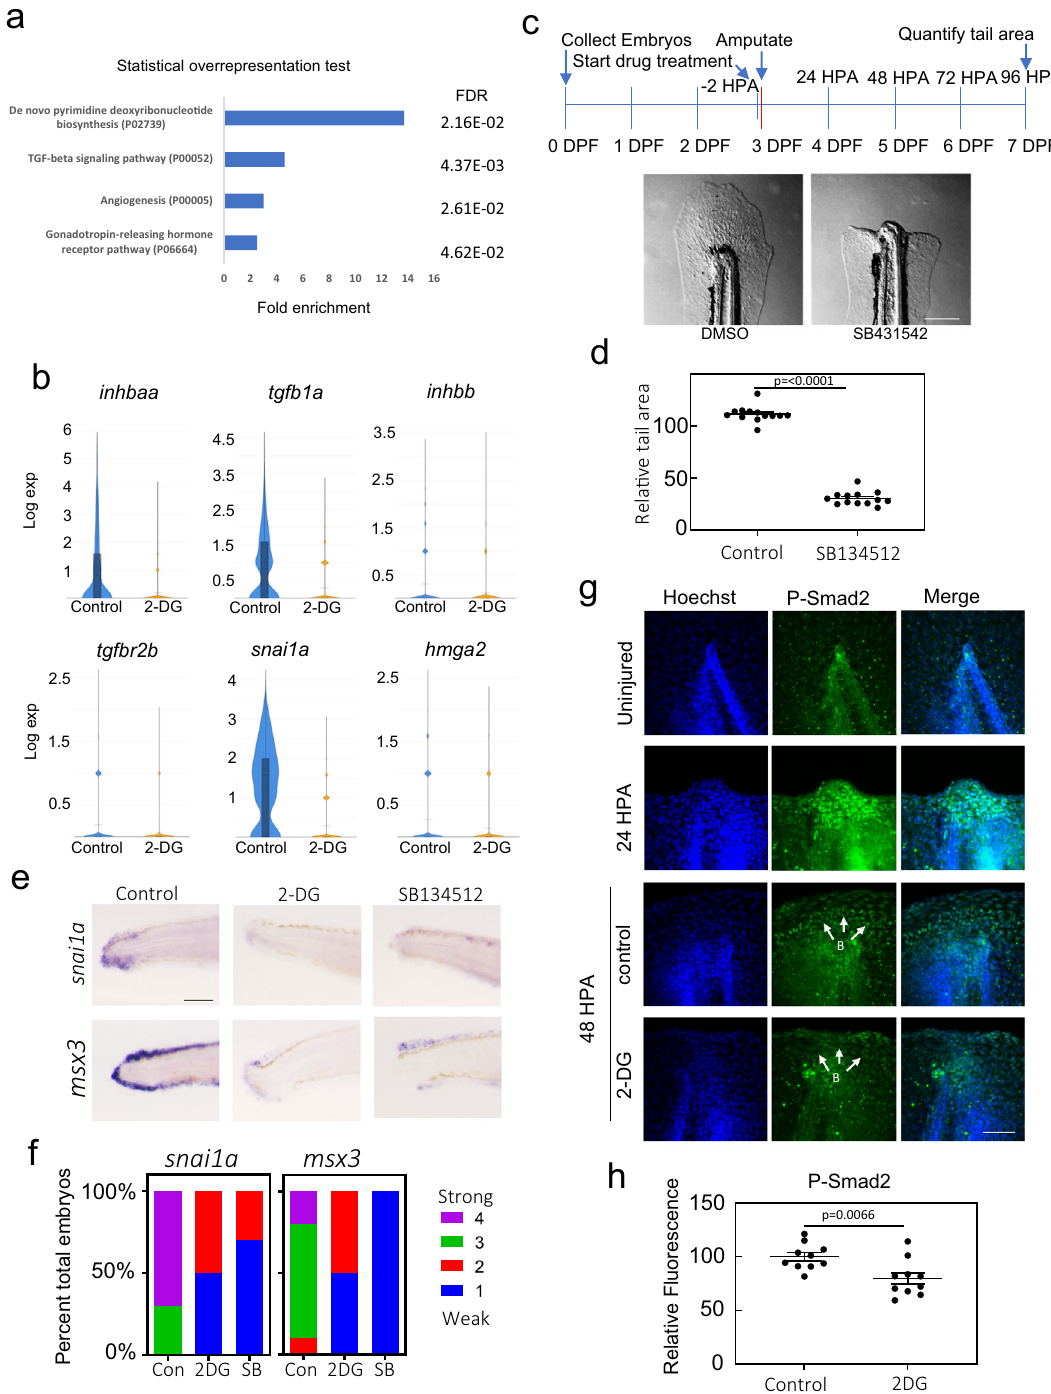
Fig. 5 TGF- β signaling is essential for development of blastema. a Panther Pathways signi fi cantly overrepresented by genes repressed by 2-DG in the blastema (Cluster 2). b Violin plots of tgfb1, inhbaa, inhbb, tgfbr2b, snai1a , and hmga2 expression in control and 2-DG treated blastemas (cluster 2). c Image of the tail of a 96 HPA embryo treated with DMSO or the Alk4, 5, and 7 inhibitor SB431542. Drug was added to embryo media 2 h prior to amputations and treatment persisted through the duration of experiment. Scale bar = 200 µm. d Quanti fi cation of tail area of 96 HPA embryos treated with DMSO or SB431542. Drug was added to embryo media 2 h prior to amputations and treatment persisted throughout the duration of experiment. Mean and SEM are shown. N = 13 for each condition. Statistics were determined with an unpaired two-tailed t -test. e In situ hybridization of snai1a and msx3 in DMSO, 2-DG, or SB431542 treated 48 HPA embryos. Scale bar = 100 µm. f Stacked percentage graph of snai1a and msx3 expression as determined by in situ hybridization. A score of 1 represents little to no staining, while a score of 4 represents strong staining. N = 10 embryos for all conditions. g Immuno fl uorescent staining of P-SMAD2 in uninjured, 24 HPA, and 48 HPA control or 2-D treated embryos. Images are sum z-stack projections of 1 µM slices through the entire embryo. B indicates predicted blastema. Scale bar = 50 µm. h Quanti fi cation of P-Smad2 intensity in the blastema. Mean and SEM are shown. N = 10 embryos for all conditions. Statistics were determined with an unpaired two-tailed t